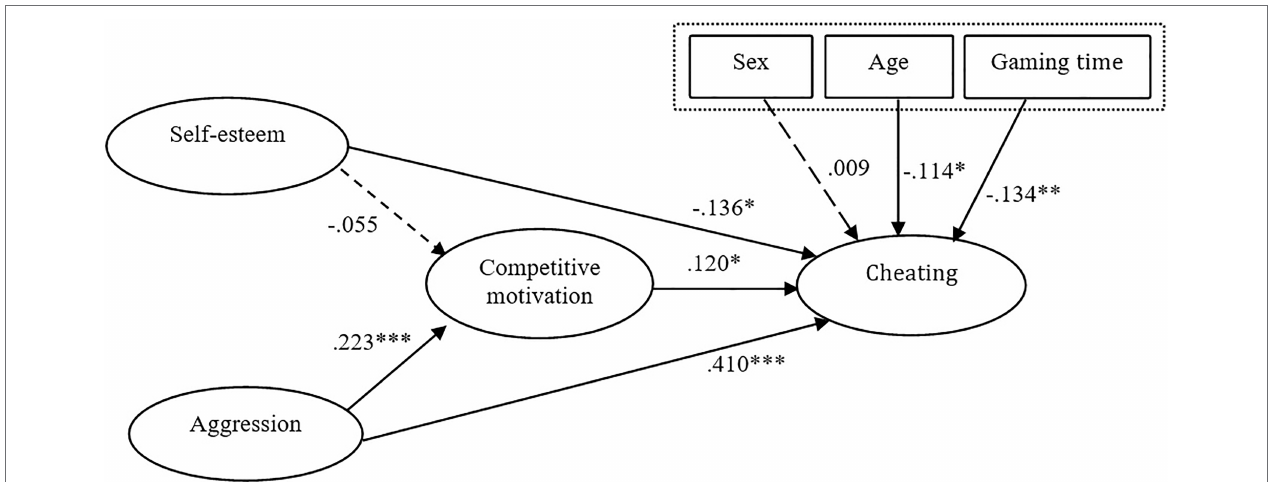
FIGURE 1 | Results of structural equation model. * p < 0.05; ** p < 0.01; and *** p < 0.001.